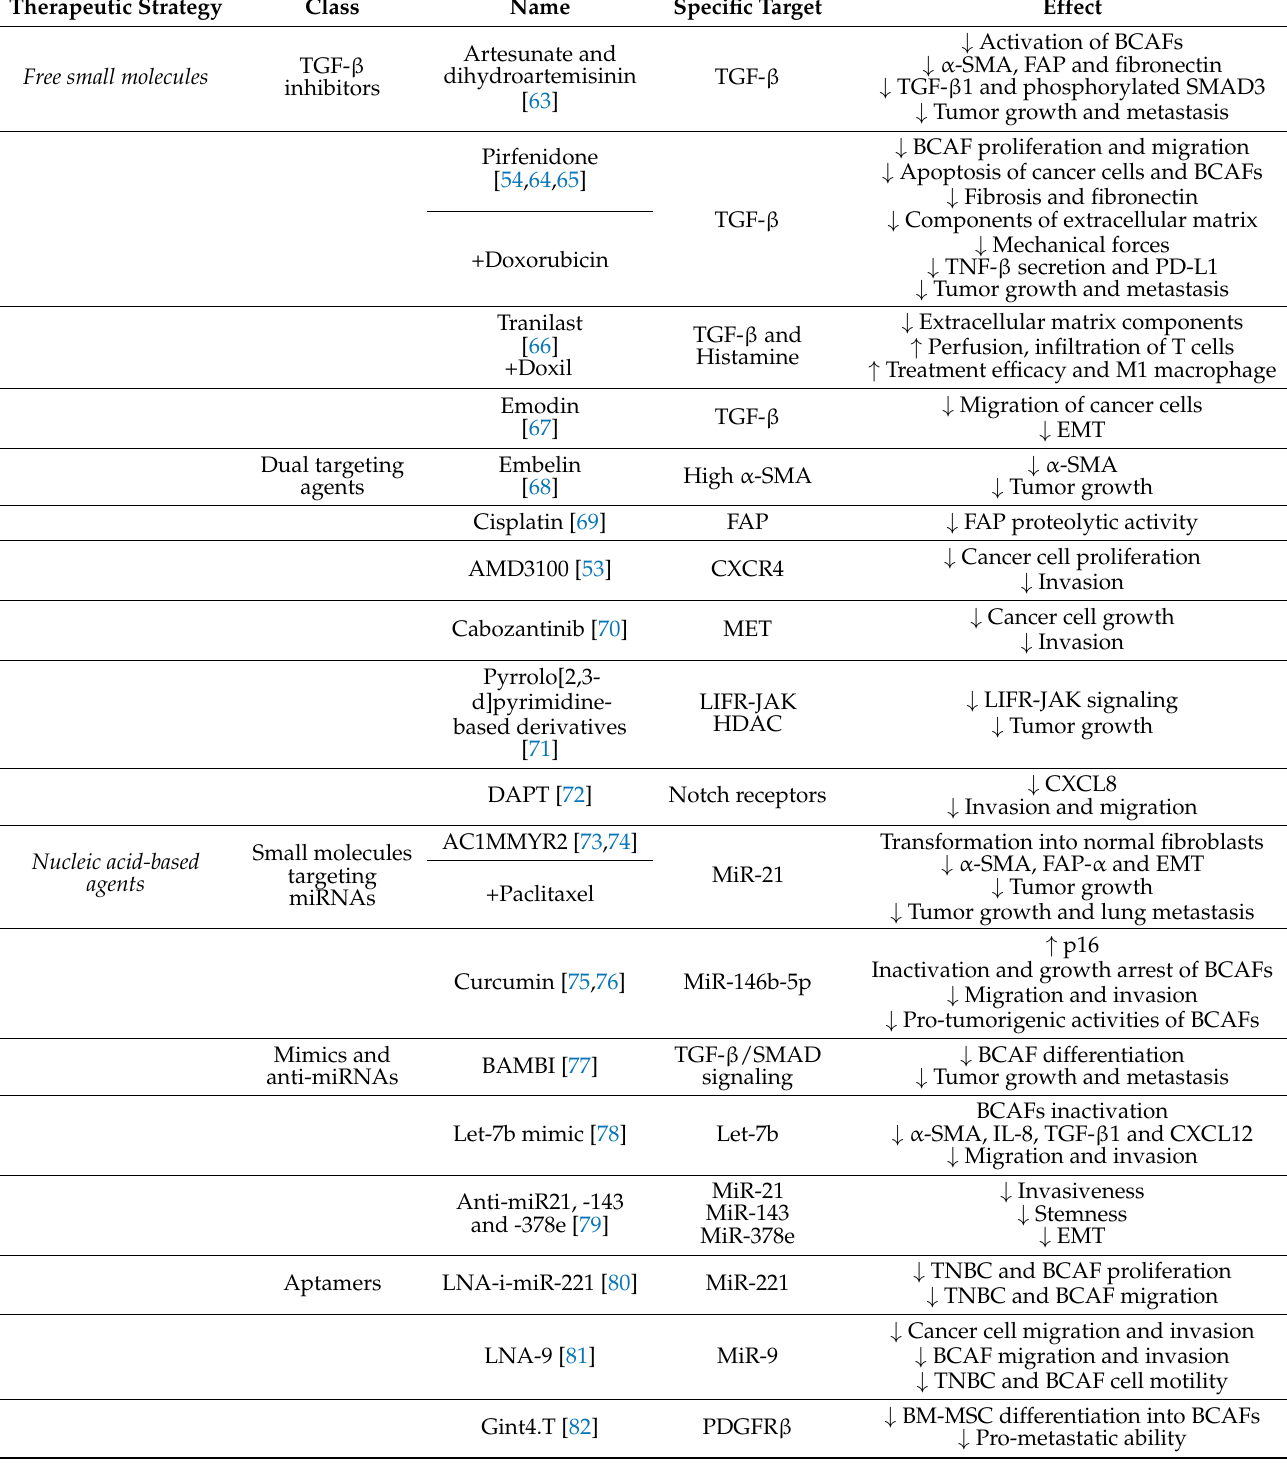
Table 1. BCAF targeting therapeutic candidates (free small molecules and nucleic acid-based agents) in